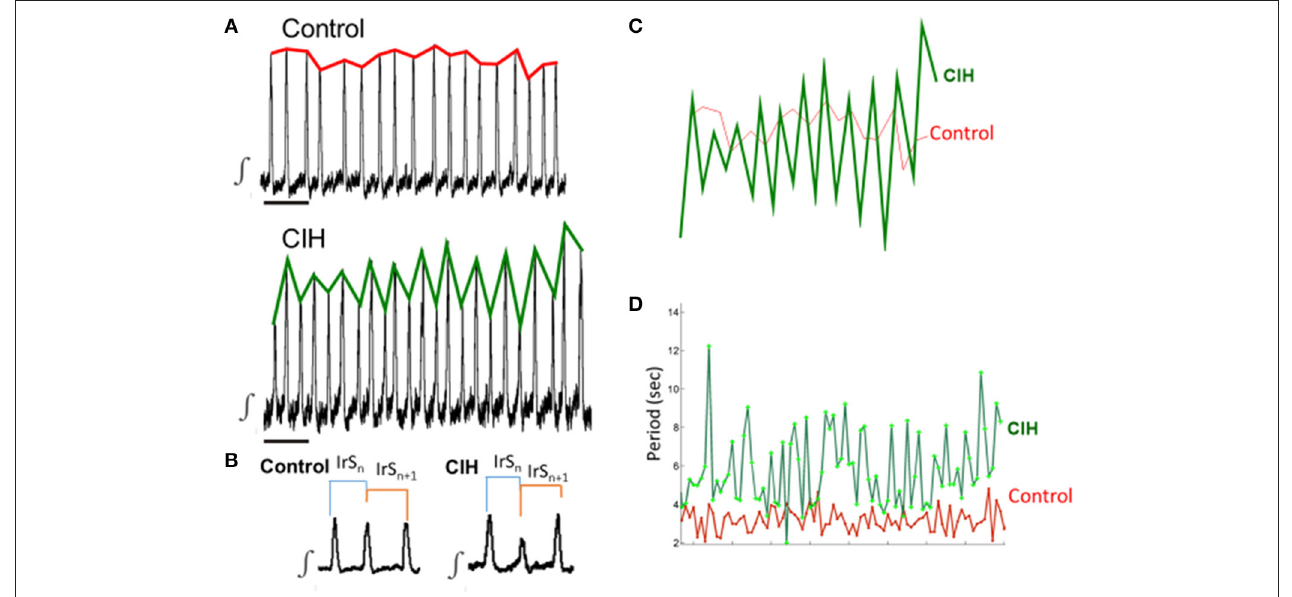
FIGURE 1 | Fluctuations in network parameters can be detected and characterized by different methods. (A) Representative examples of integrated traces of preBötC activity from the control (top) and CIH (bottom) groups. Red line highlights the periodic fluctuation in burst amplitude throughout the control rhythm. Green line highlights the periodic fluctuation in burst amplitude throughout the time-series. Scale bar: 10s. (B) Expanded traces of representative rhythms from ( A) group illustrating the time window for the calculation of irregularity score (IrS) for the n th and the n th + 1 cycles (i.e., the burst to burst window) for both control and CIH rhythms. (C) Overlay of the fluctuation of burst amplitudes for the control rhythm in (A) (red) and the CIH rhythm in (B) (green) demonstrating the presence of fluctuations in both rhythms yet larger in magnitude in the CIH group. The gain of fluctuations can be described by the fluctuation value ( χ ) see methods for formula. (D) Example of the fluctuation of period for a control rhythm (red) and a CIH rhythm (green). Representative integrated traces showing the fluctuations in period can be observed in Figure 2 , 4 .